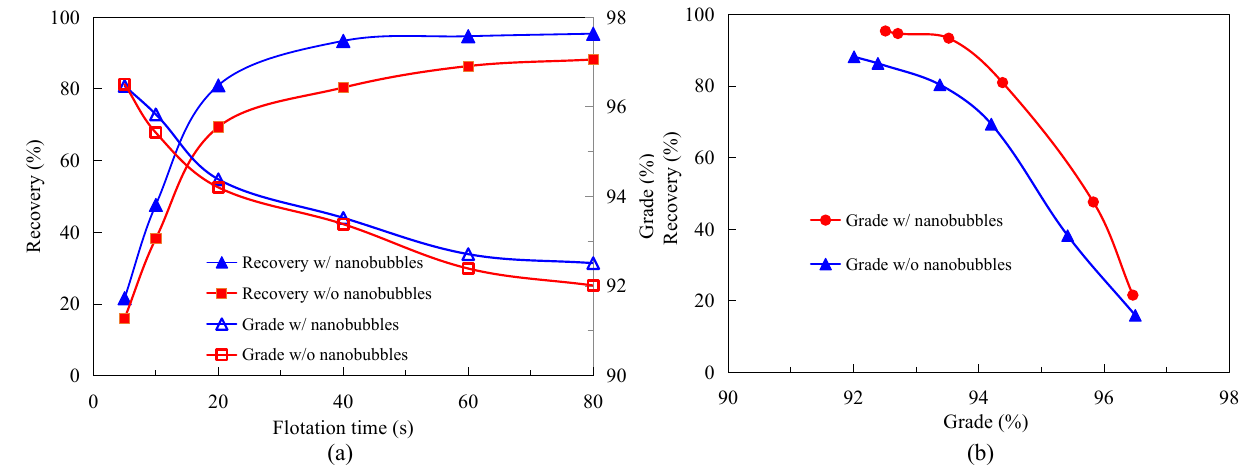
Figure 4. The results of kinetic flotation test with MFPO: ( a ) concentrate recovery and grade as a function of flotation time in the presence and absence of nanobubbles; ( b ) concentrate recovery as a function of concentrate grade in presence and absence of nanobubbles.